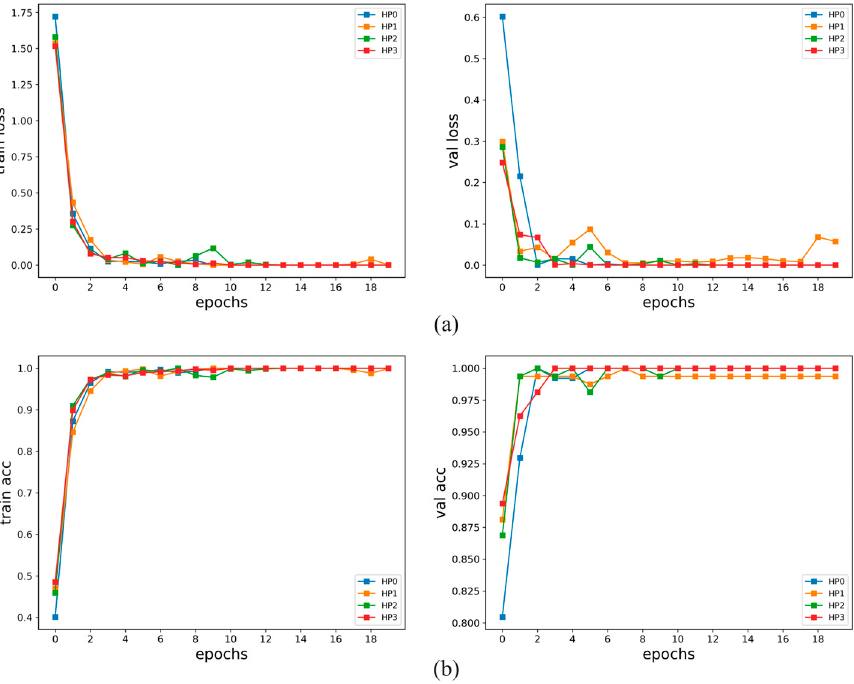
Figure 16. Training results of four load conditions: ( a )Train loss and val loss, ( b ) Train acc and val acc.